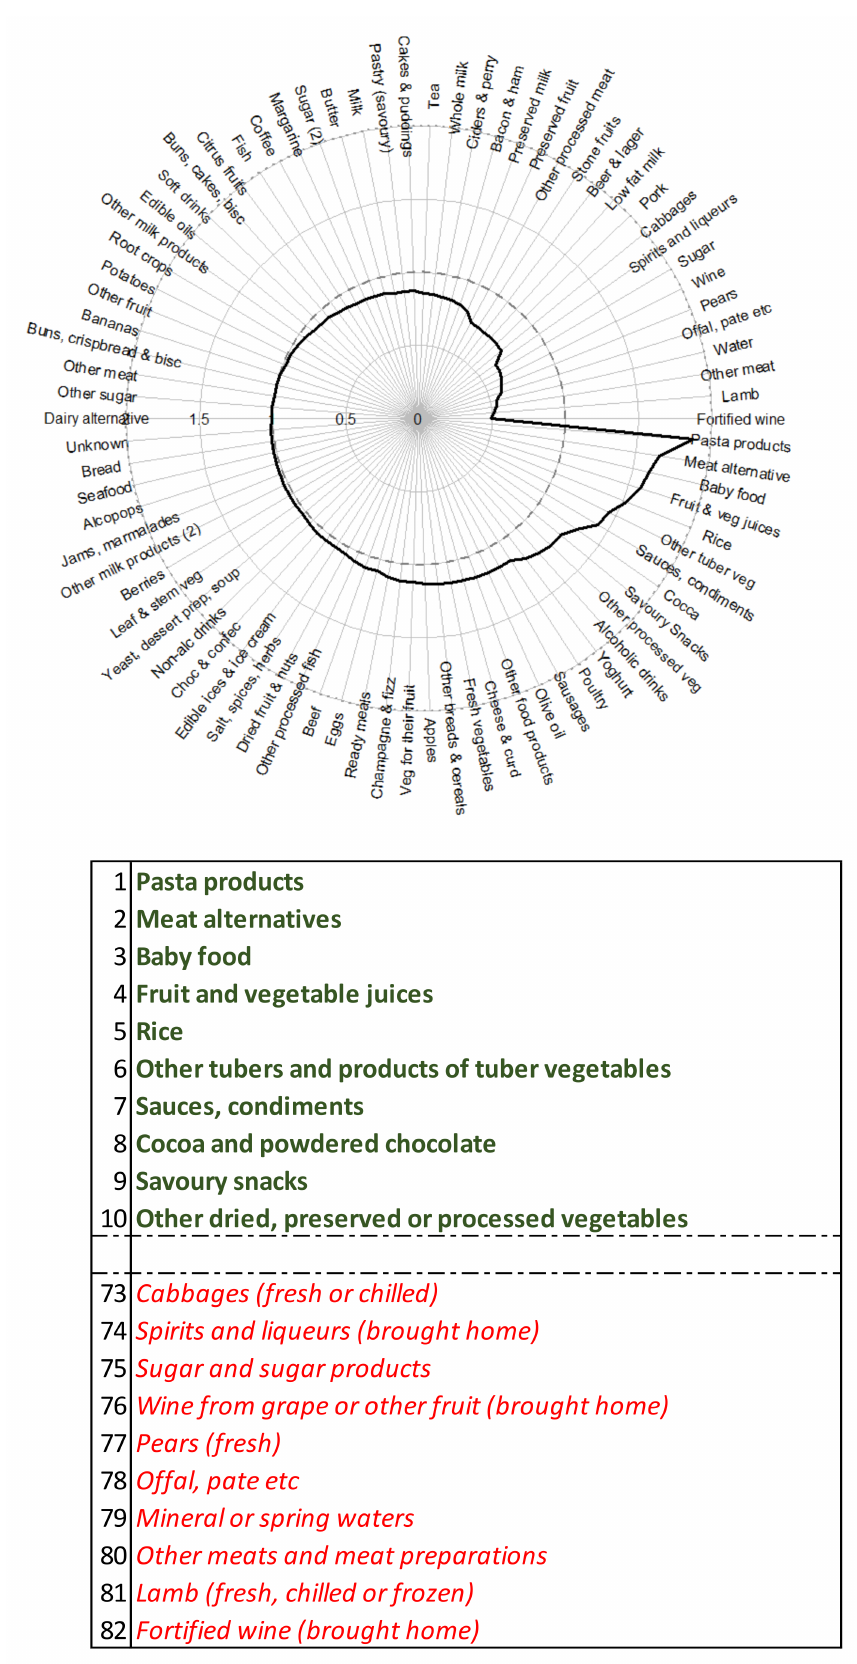
Figure A2. Meat Alternatives ( n =